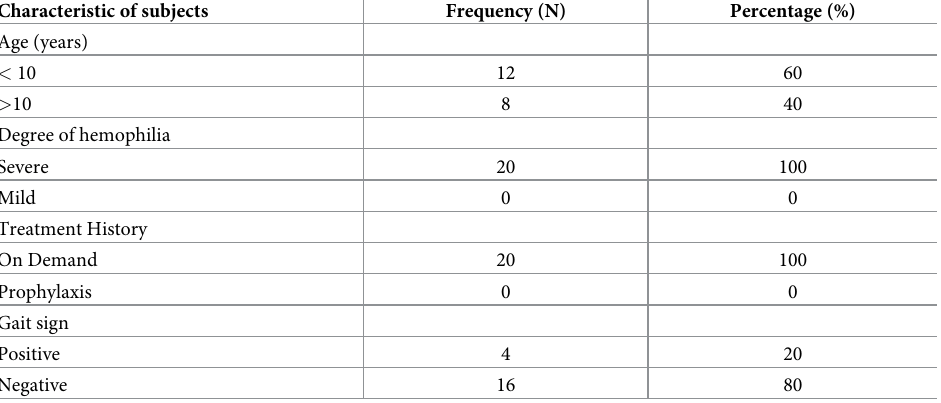
Table 1. Characteristic of